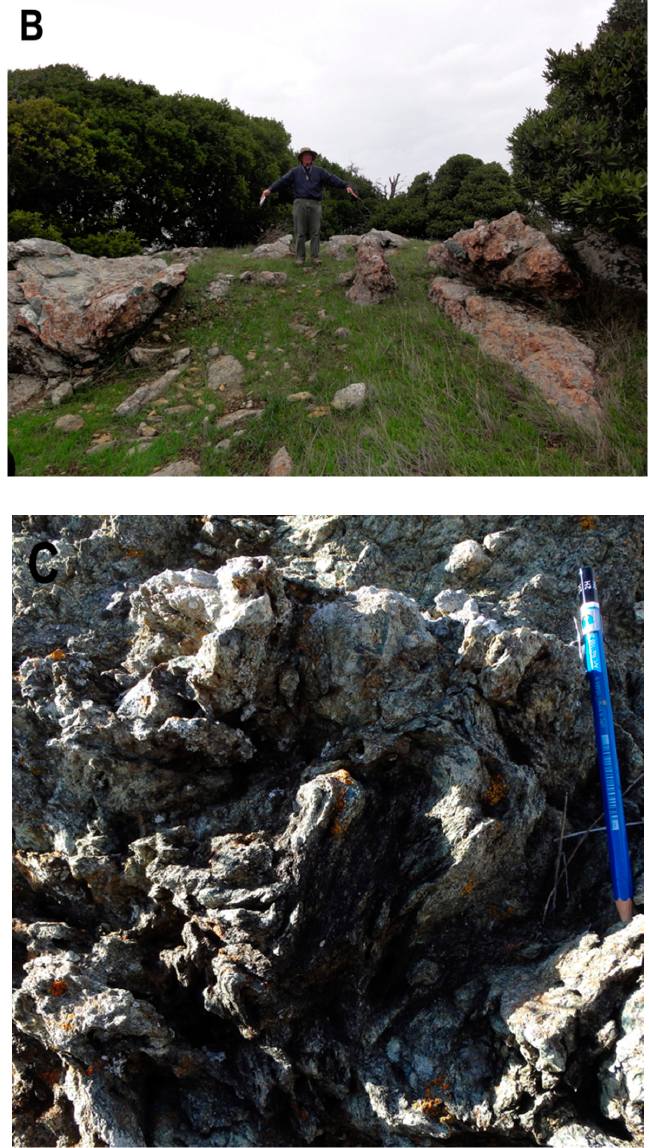
Figure 7. Some structures in serpentinite-matrix mélanges. ( A ) Boudin and foliation. The foliation in the serpentinite matrix (dark) bends to wrap around a large chert block (light) in the Jenner Headlands Mélange. Note the bend in foliation towards parallelism with the contact at the lower right behind grass and at the left center, where the matrix encloses a small boudinaged layer of chert (modified from [54]); 40 cm hammer provides scale. ( B ) Folds in exotic serpentinite tectonite (schist) block in the Ring Mountain Mélange. Author’s arms point in directions of dip, away from the antiformal axis. Note the smaller synformal fold axial region to the left. ( C ) Folds in the serpentinite matrix of Ring Mountain Mélange. Pencil, for scale, is about 6 cm long.